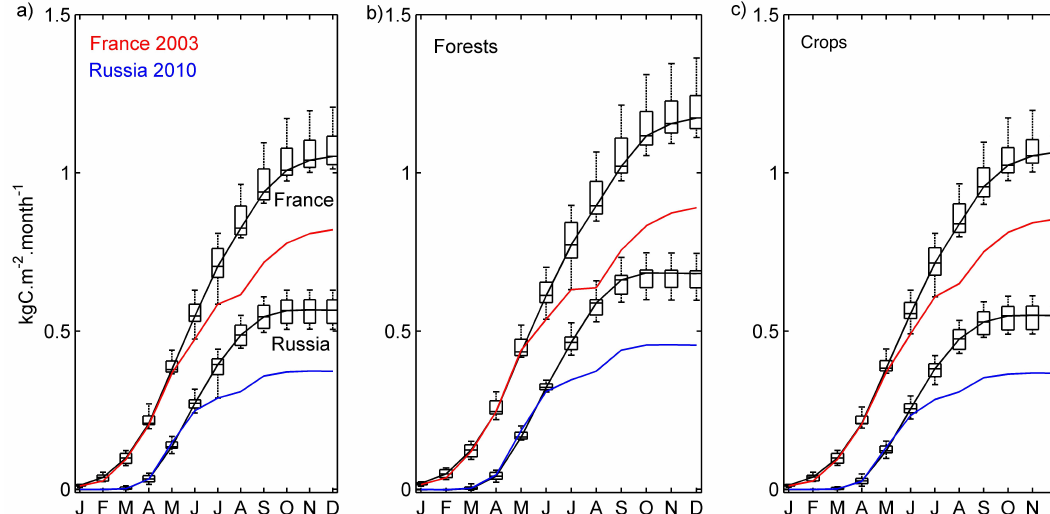
Figure 4. (a) Accumulated monthly PsN (from MOD17A2) climatology (box plots and black lines) for the two selected regions HW03 and HW10. Boxes represent the ± 0.5 σ range and whiskers extend to the most extreme data that are not outliers. Accumulated monthly PsN for 2003 in region HW03 (red) and for 2010 in region HW10 (blue). (b) and (c) as in (a) but for forests and crops, respectively.